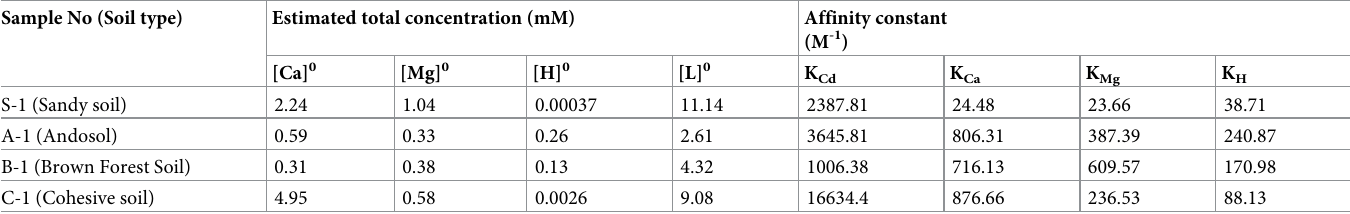
Table 4. Estimated total concentrations of Ca, Mg, H and ligand (L) (mM) for artificially contaminated soils and affinity constants of biotic ligand model (M -1 ). Sample No (Soil